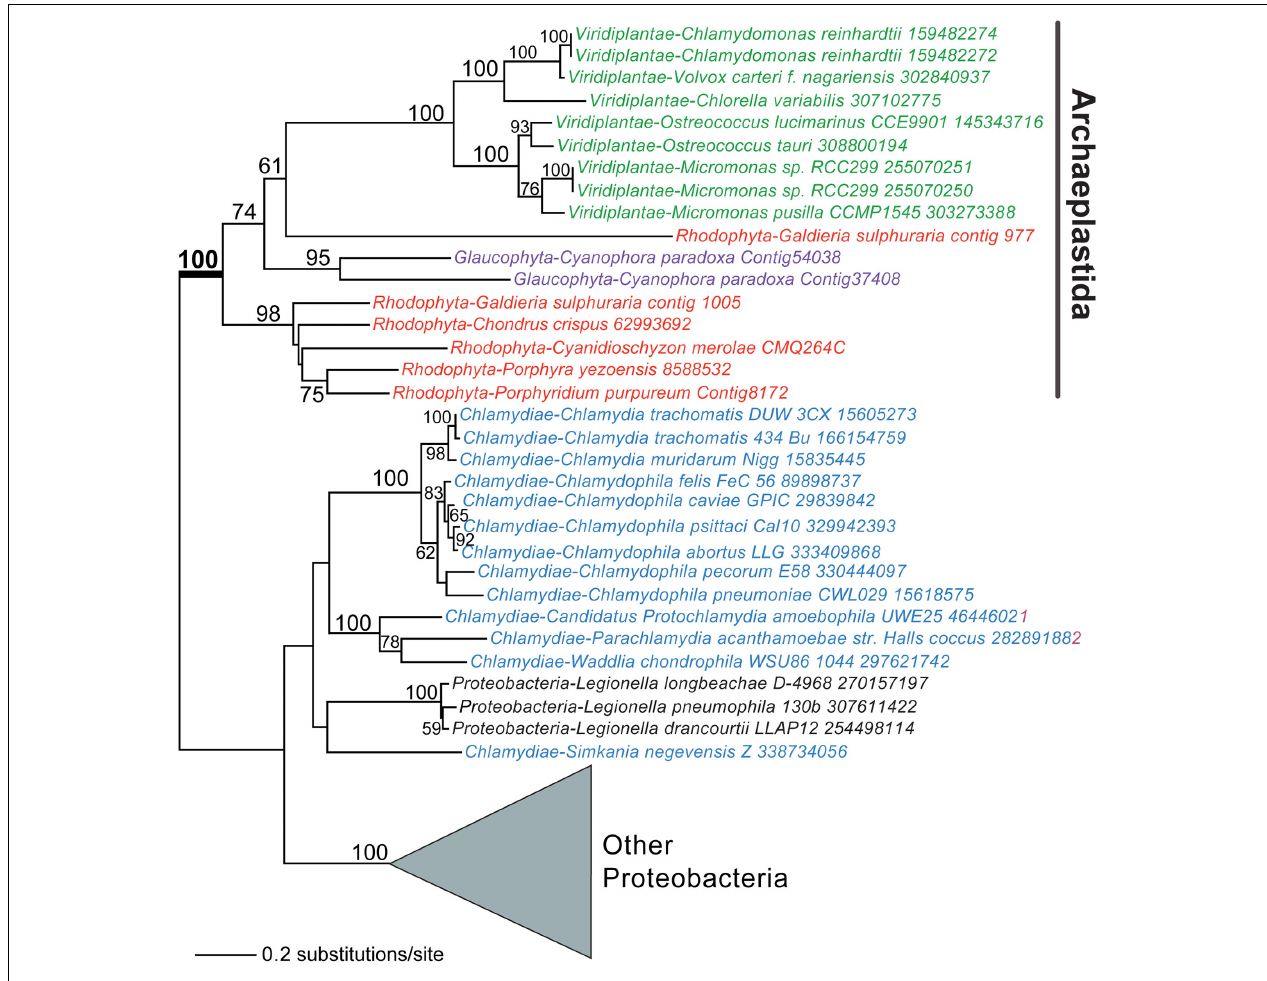
FIGURE 2 | A chlamydial or proteobacterial origin for plastid hexose-phosphate transporters. Maximum likelihood (PhyML) phylogeny of UhpC-type hexose-phosphate transporters in algae, plants, and bacteria (for